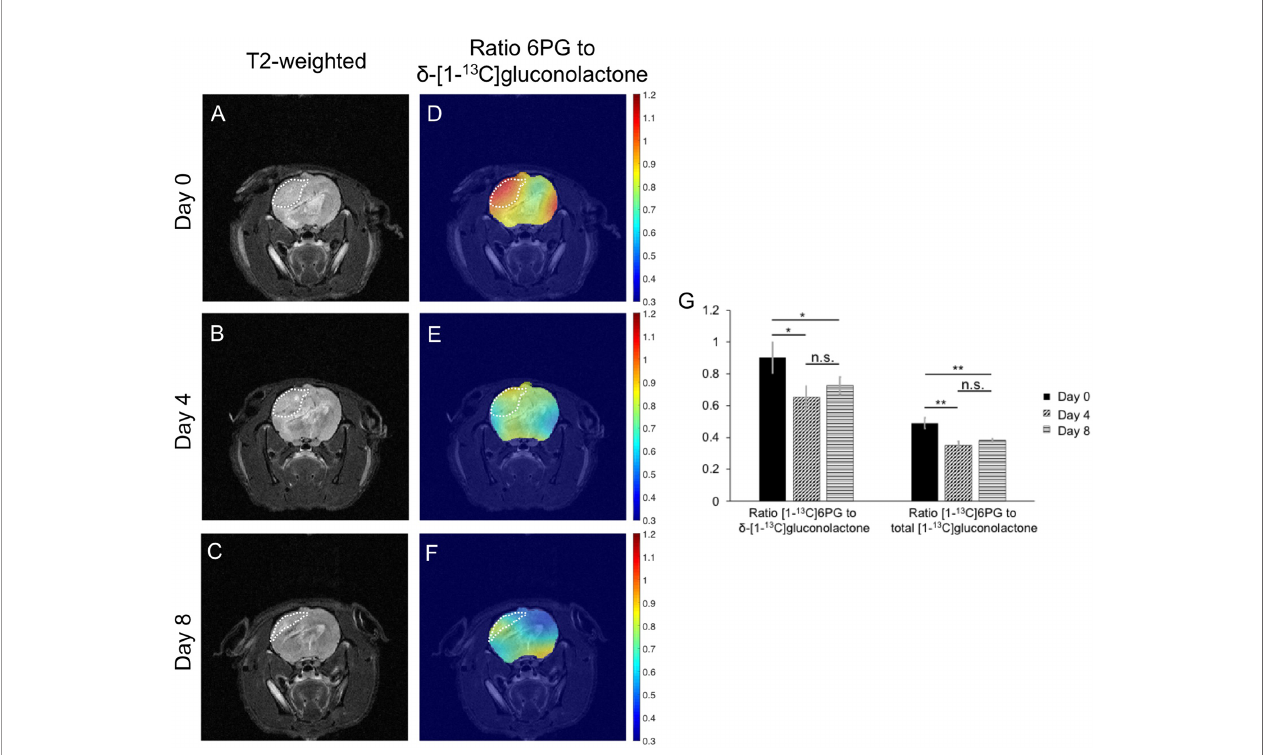
FIGURE 9 | Hyperpolarized d -[1- 13 C]gluconolactone can be used to monitor response to TMZ in vivo . Representative T2-weighted MRI (A-C) and metabolic heatmaps of the ratio of [1- 13 C]6PG to d -[1- 13 C]gluconolactone (D-F) from a rat bearing an orthotopic U251 tumor xenograft at day 0, day 4 and day 8 following treatment with TMZ. The tumor region is contoured by white dotted lines. (G) Quanti fi cation of the ratio of [1- 13 C]6PG to d -[1- 13 C]gluconolactone or the ratio of [1- 13 C]6PG to total [1- 13 C]gluconolactone from an ROI within the tumor at day 0, day 4 and day 8 of TMZ treatment in rats bearing orthotopic U251 tumor xenografts (n = 4 at day 0 and n = 3 at day 4 and 8). * indicates p<0.05, ** indicates p<0.01: ns indicates non signi fi